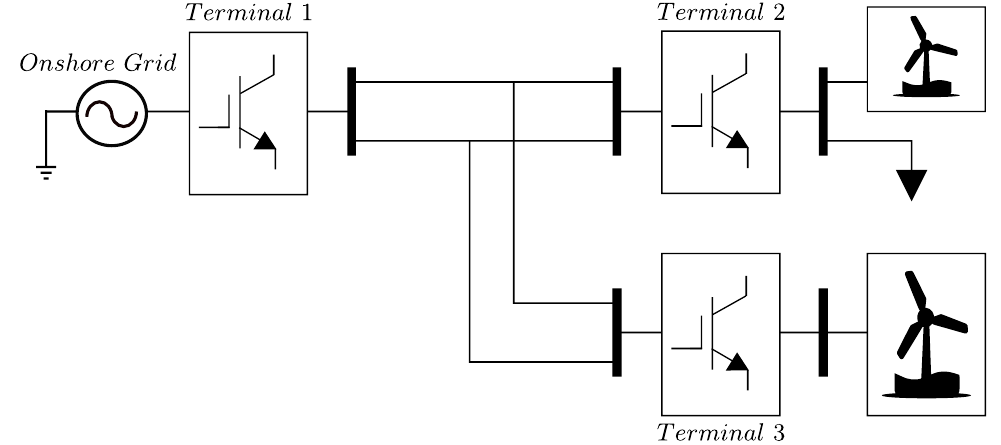
Figure 4. Three-terminal MT-HVDC network simulated in Matlab’s Simscape